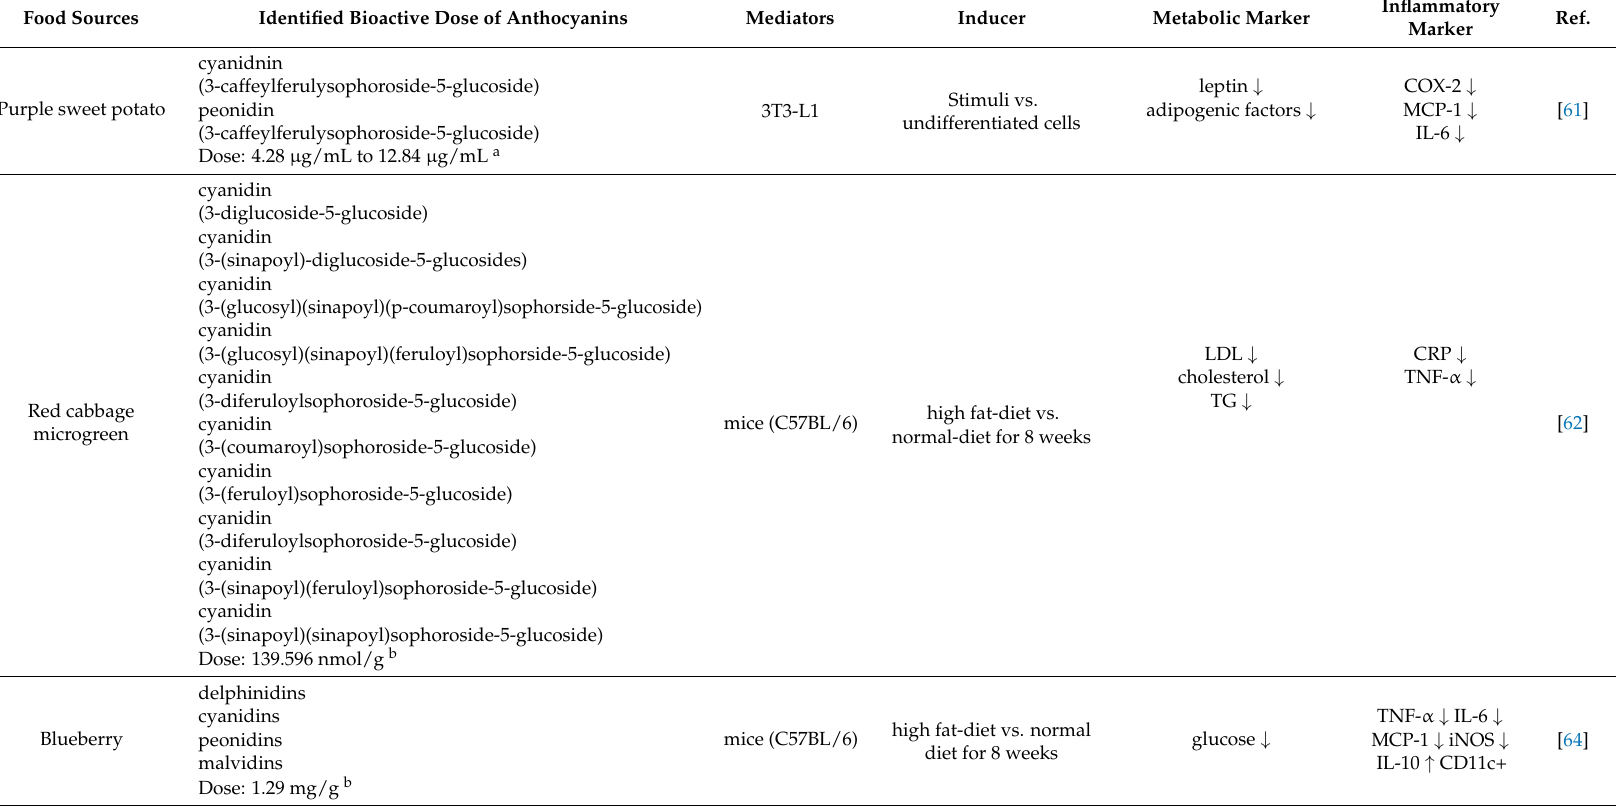
Table 2. Effects of dietary anthocyanins on obesity and inflammation (cell and animal